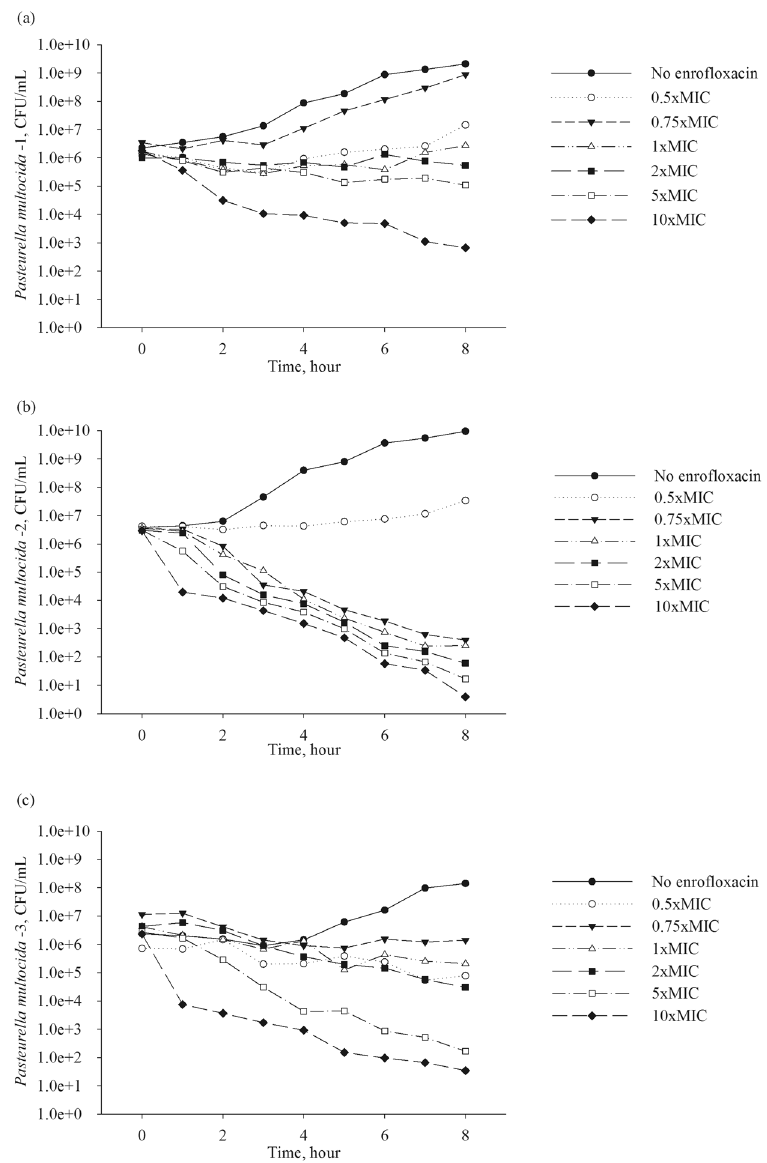
Figure 2. Data from time-kill experiments with the fluoroquinolone enrofloxacin for three isolates of Pasteurella multocida from bovine respiratory disease cases. For each isolate and enrofloxacin concentration combination, the average result of at least two replicates of the experiment is plotted. (The isolate number corresponds to that in Table